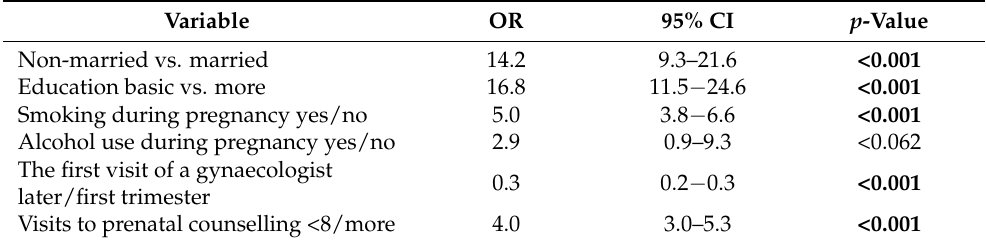
Table 3. OR of various risk variables for adolescent mothers’ reproductive